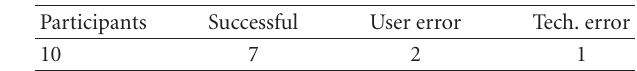
Table 1: Usability